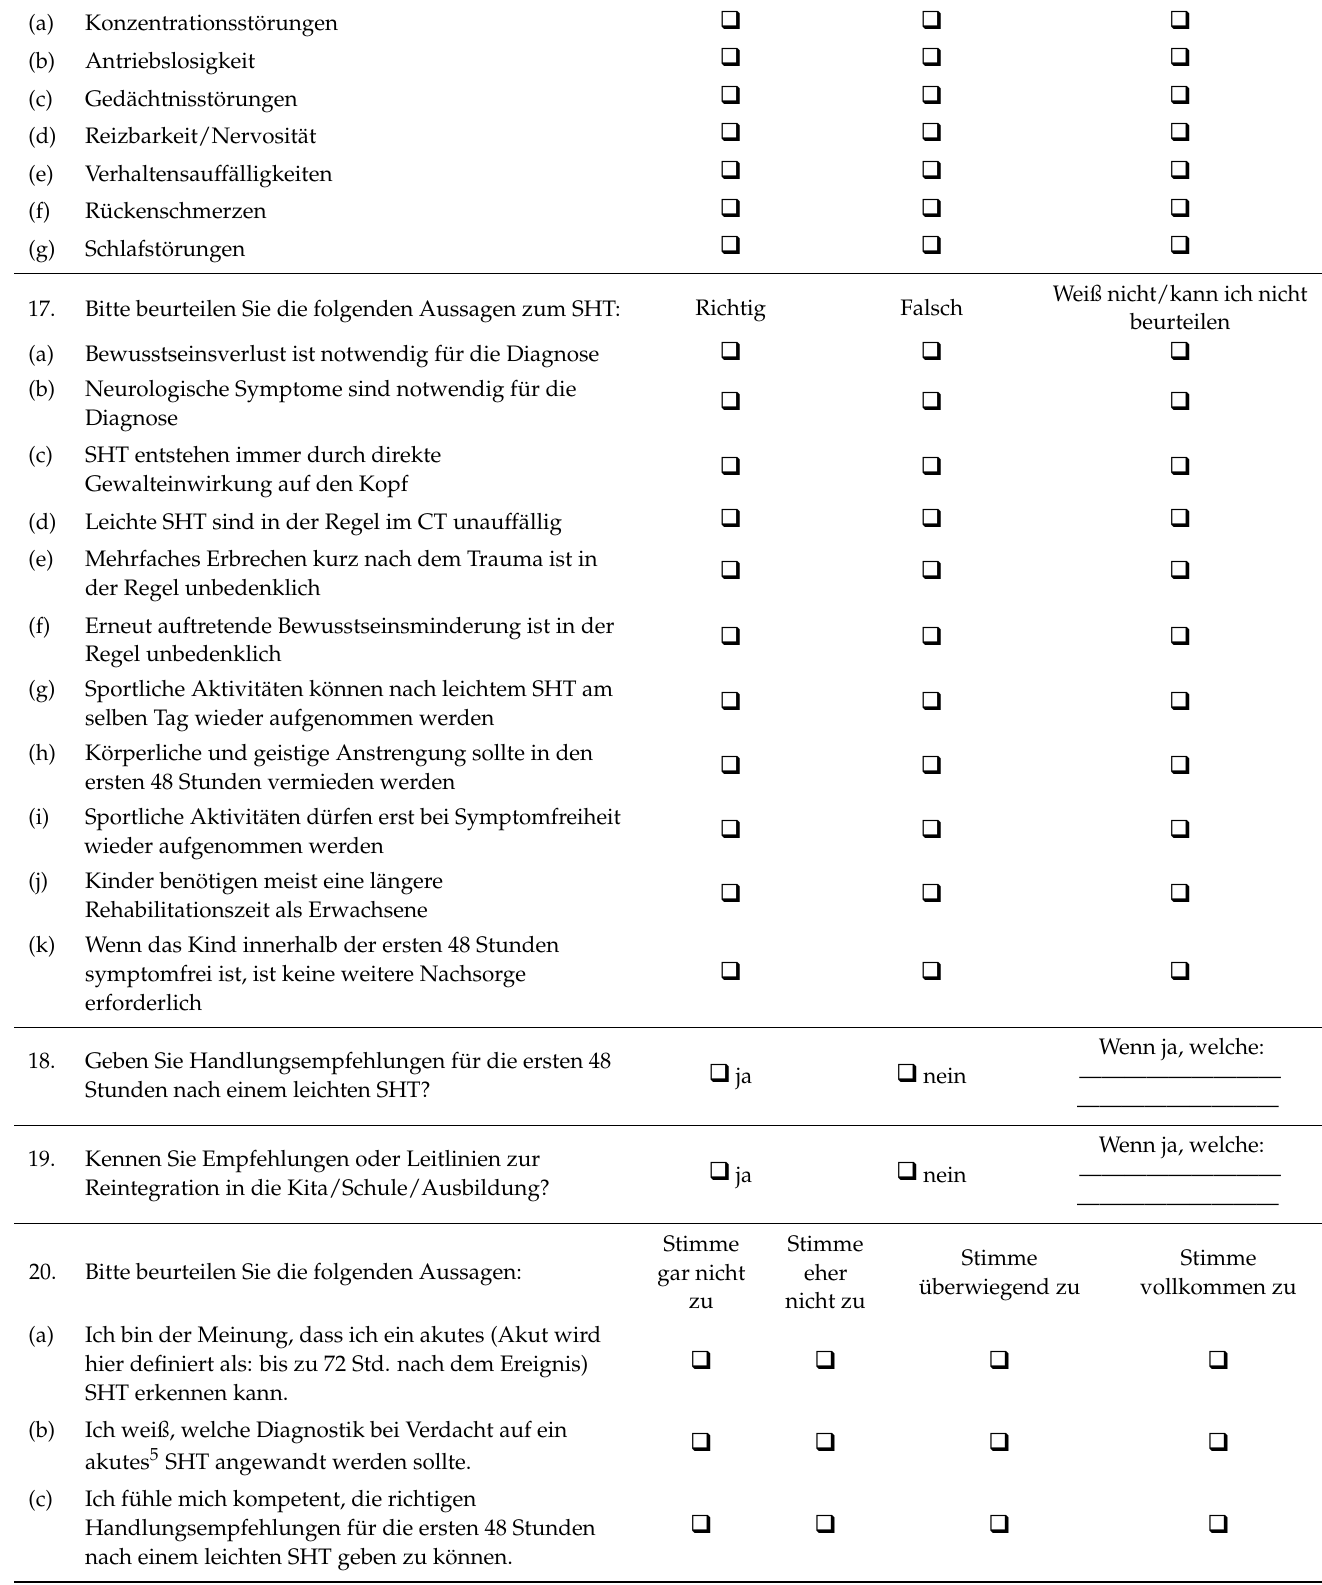
Behandlern weitergegeben